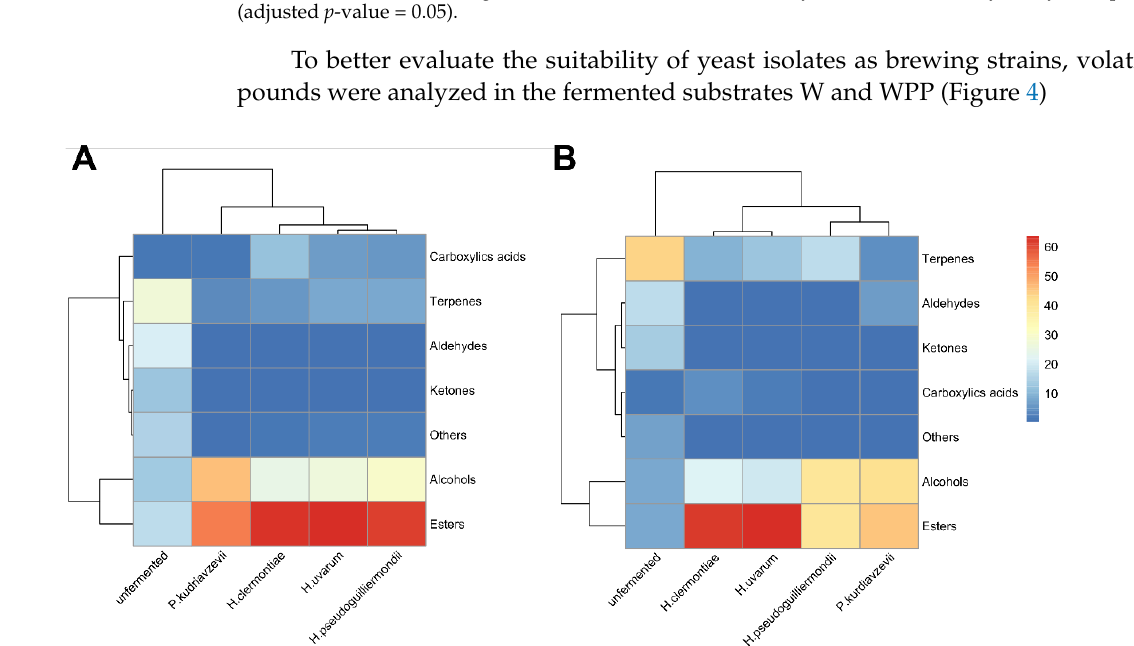
Data are means ± standard deviations of three to five independent measurements. The same superscript letters in the same row indicate not significant differences as determined by ANOVA followed by Tukey HSD post-hoc test (adjusted p -value = 0.05).